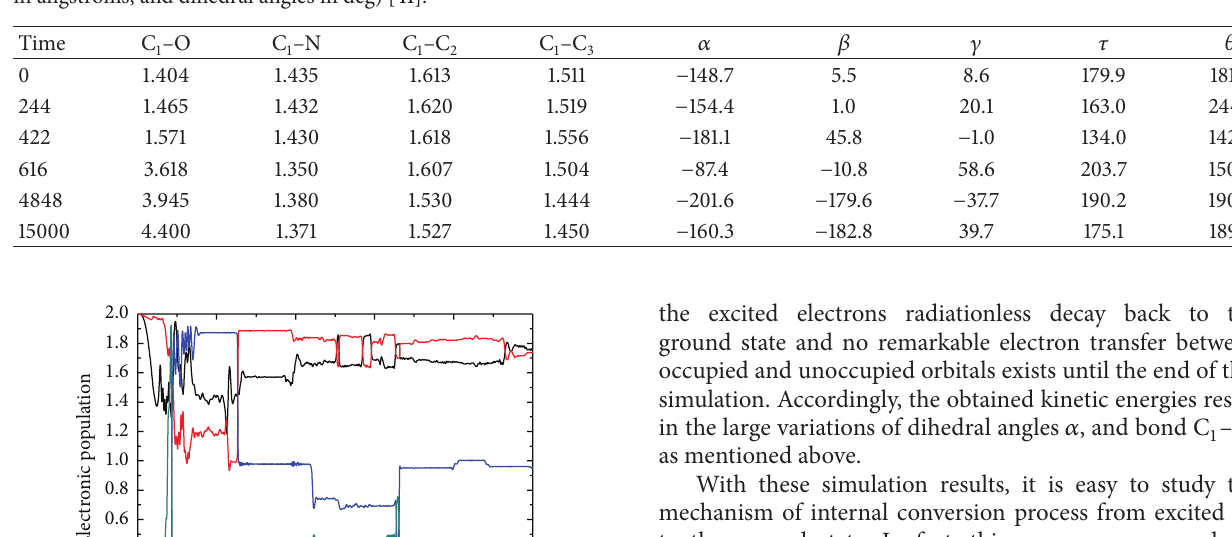
Table 3: Key geometry parameters for the dynamic simulation of photochromic ring-opening reaction of trans-SP (time in fs, bond distance in angstroms, and dihedral angles in deg) [41].